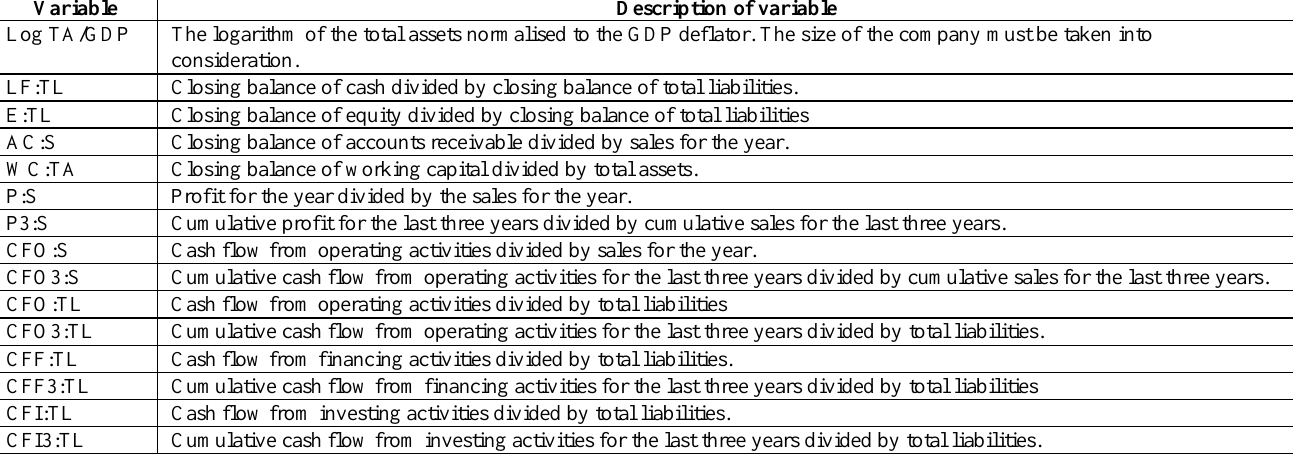
Table 1: Summary of independent variables used in the analysis Variable Description of variable Log